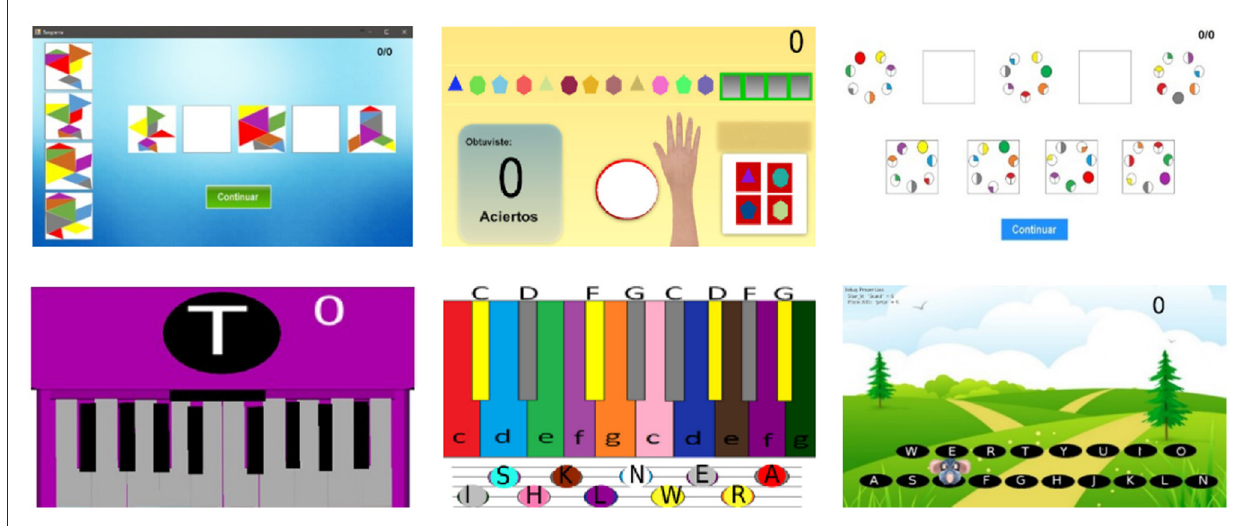
FIGURE1 Tasks implemented in the virtual environments. (Top) Cognitive task, (down) Motor task. The middle level of abstraction (middle) was used for piloting and as a baseline reference for the low (left) and high (right) levels of abstraction but was not used during